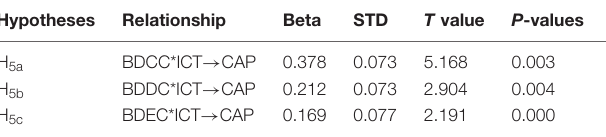
TABLE 6 | Structural model assessment (moderation